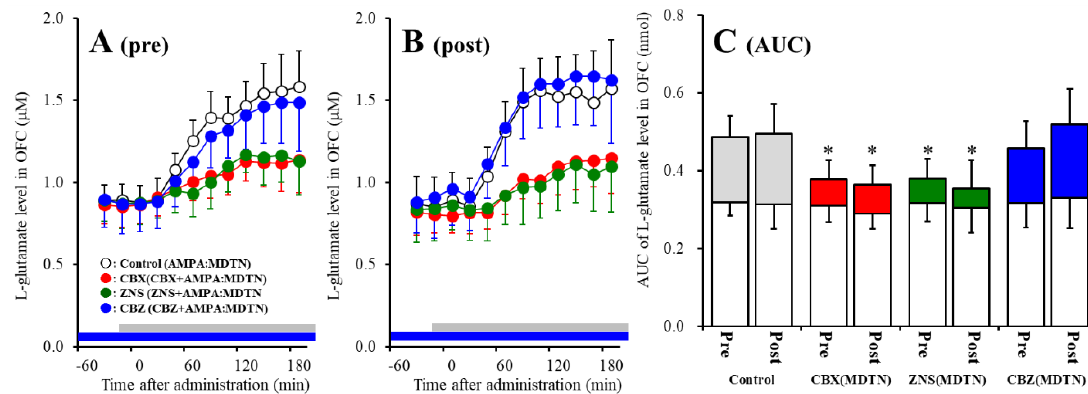
Figure 3. E ff ects of local administration of 100 µ M CBX (red circles) and therapeutic-relevant concentration of CBZ (100 µ M: blue circles) and ZNS (500 µ M: green circles) into the MDTN on pre-AMPA-evoked (panel A ) and post-AMPA-evoked (panel B ) l -glutamate release (before and after hemichannel activation induced by perfusion with FCHK-MRS into the MDTN for 20 min) in the OFC of S286L-TG. Ordinates indicate mean extracellular l -glutamate level ( µ M) ( n = 6), and abscissas indicate time after AMPA-evoked stimulations (min). Blue bars indicate the perfusion with CBX, CBZ, or ZNS into the MDTN. Gray bars indicate the perfusion with 100 µ M AMPA into the MDTN. (Panel C ) indicates AUC value of extracellular l -glutamate level (nmol) before (basal extracellular l -glutamate level) and after AMPA-evoked stimulation (from 20 to 180 min) of panels A and B. Opened columns indicate the AUC values of basal extracellular levels of l -glutamate in panel A and B. * p < 0.05; relative to control by MANOVA with Tukey’s post hoc test.